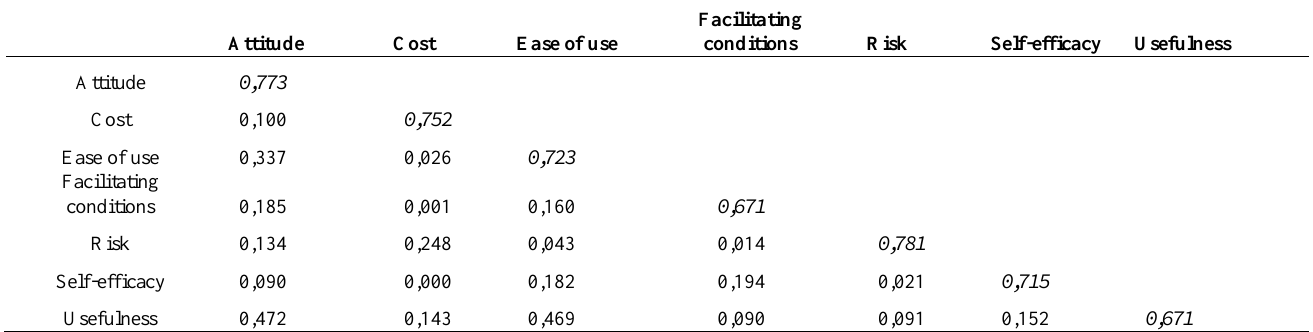
Table 3: Squared correlations between constructs in the male measurement model